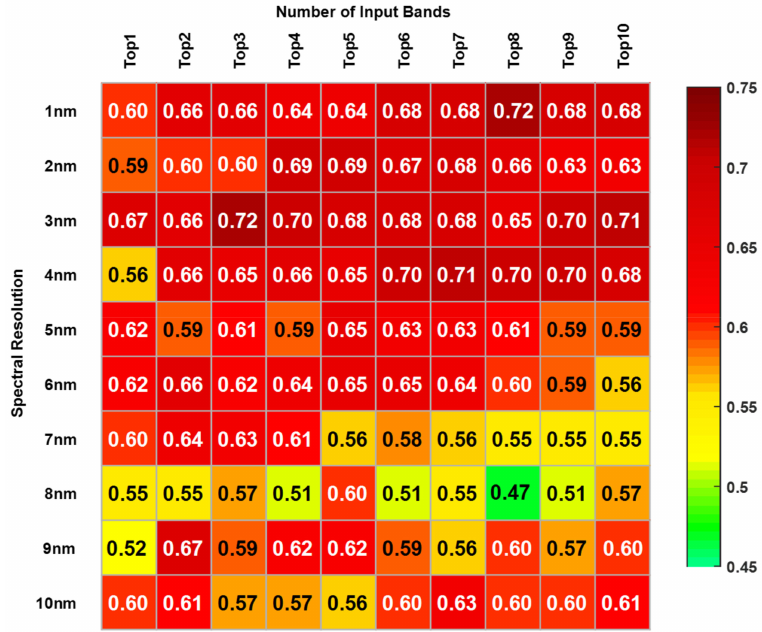
Figure 3. Diagnostic accuracies of Cd pollution diagnosing for band combination